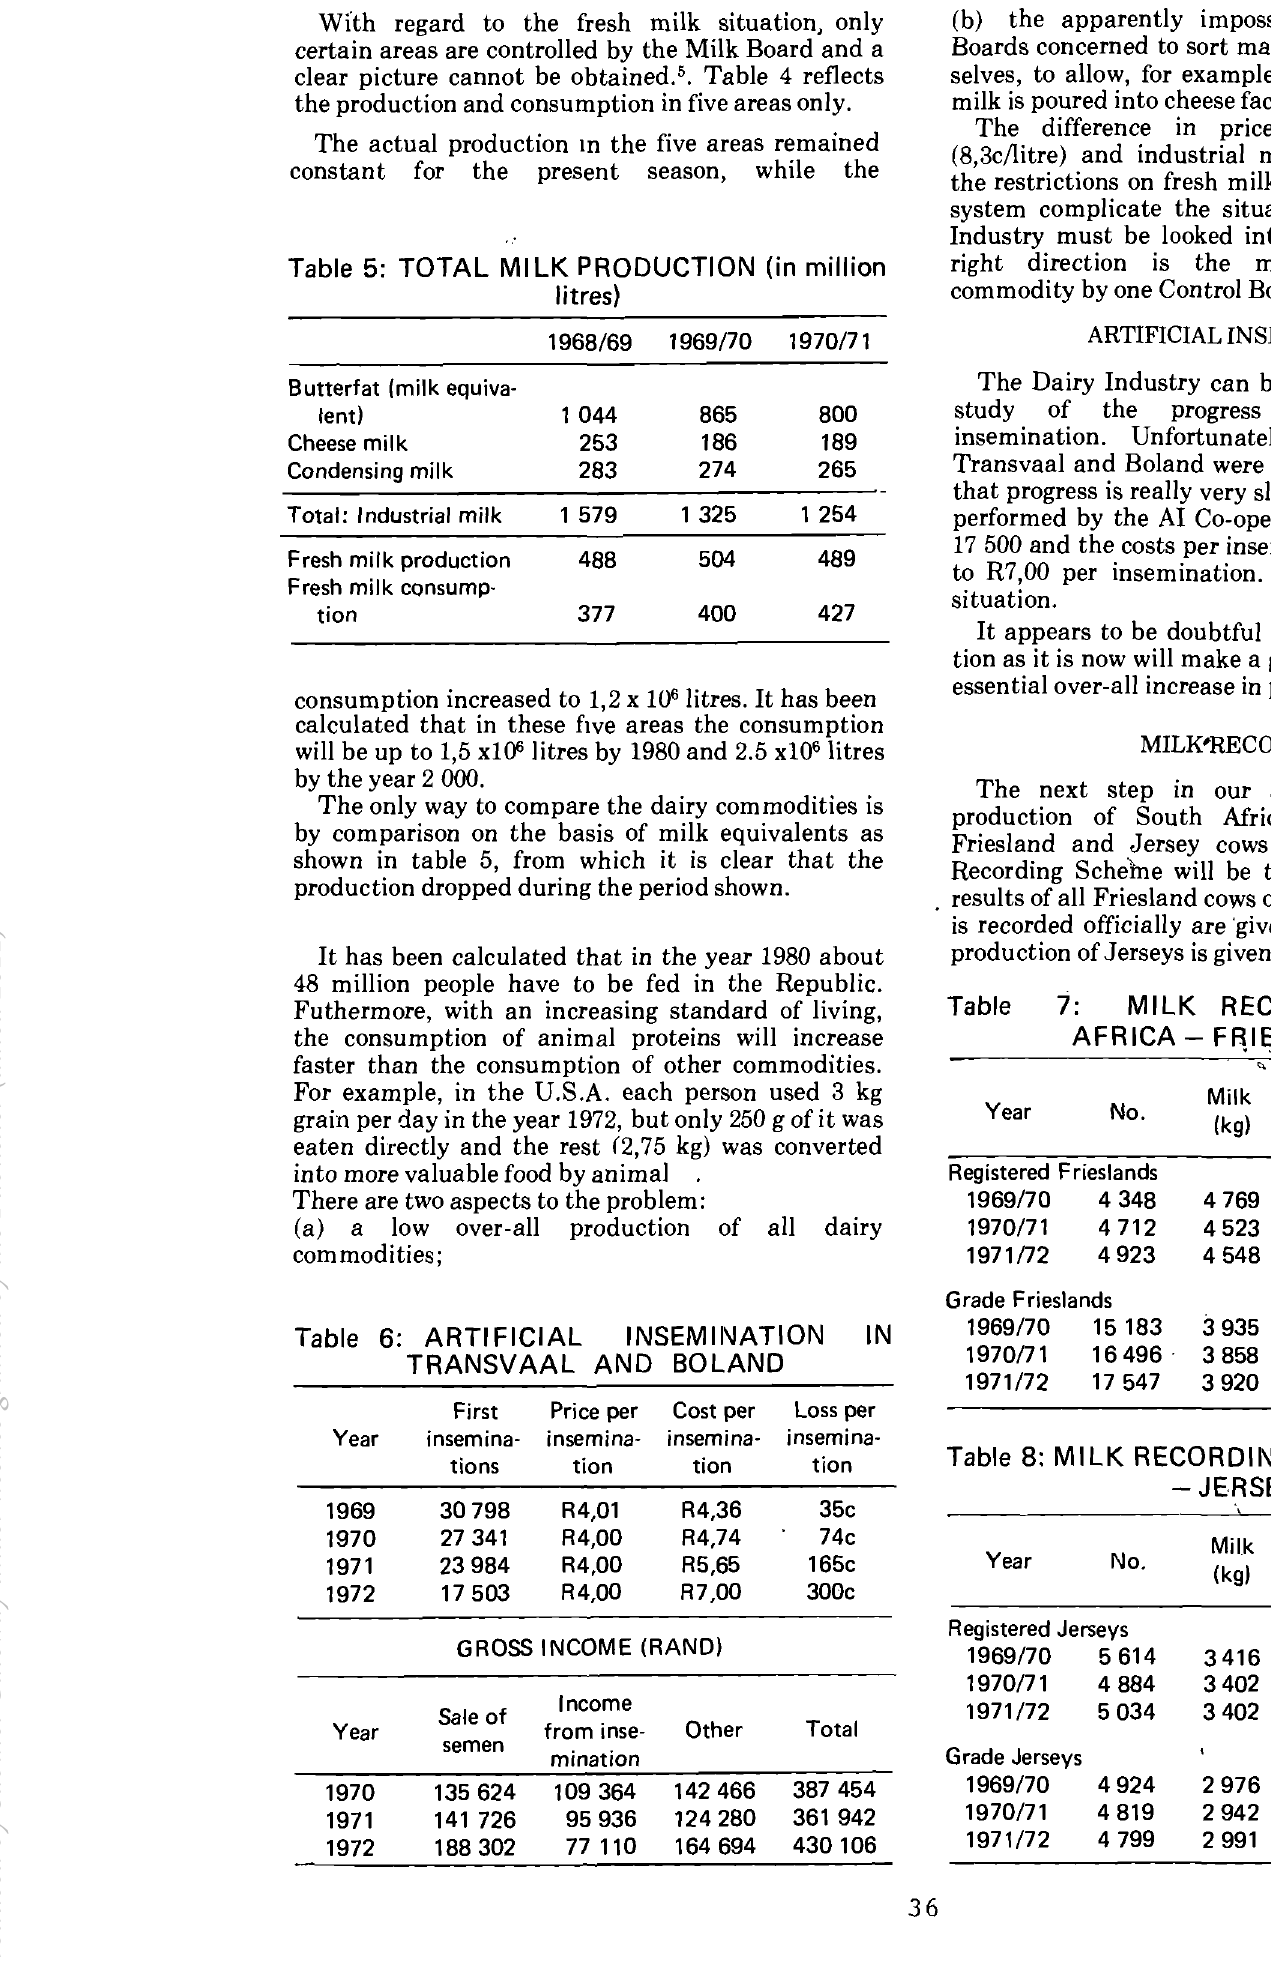
Table 8: MILK RECORDING 11\1 SOUTH